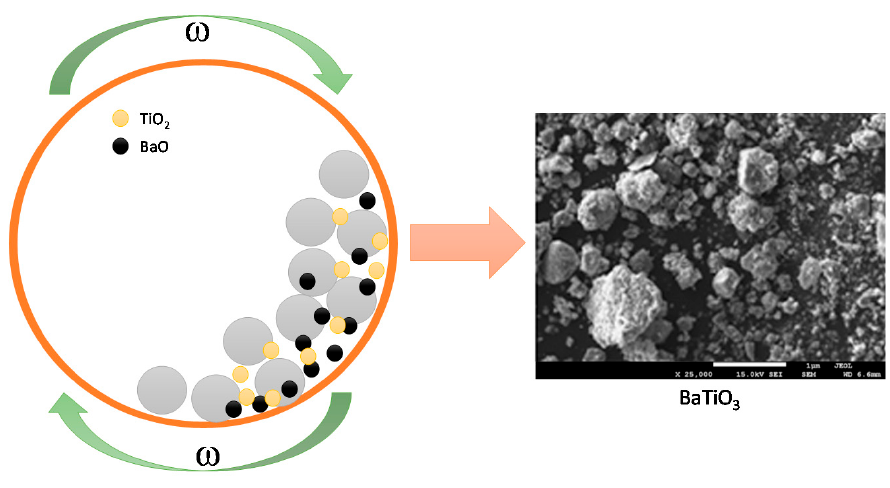
Figure 1. The scheme of the preparation of BaTiO 3 using a ball mill.